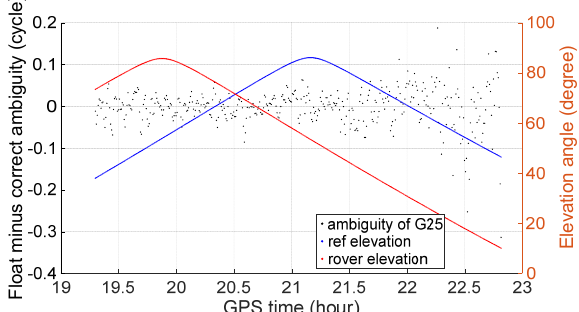
Figure 1. Ambiguity resolution of extra ‐ wide lane G25.